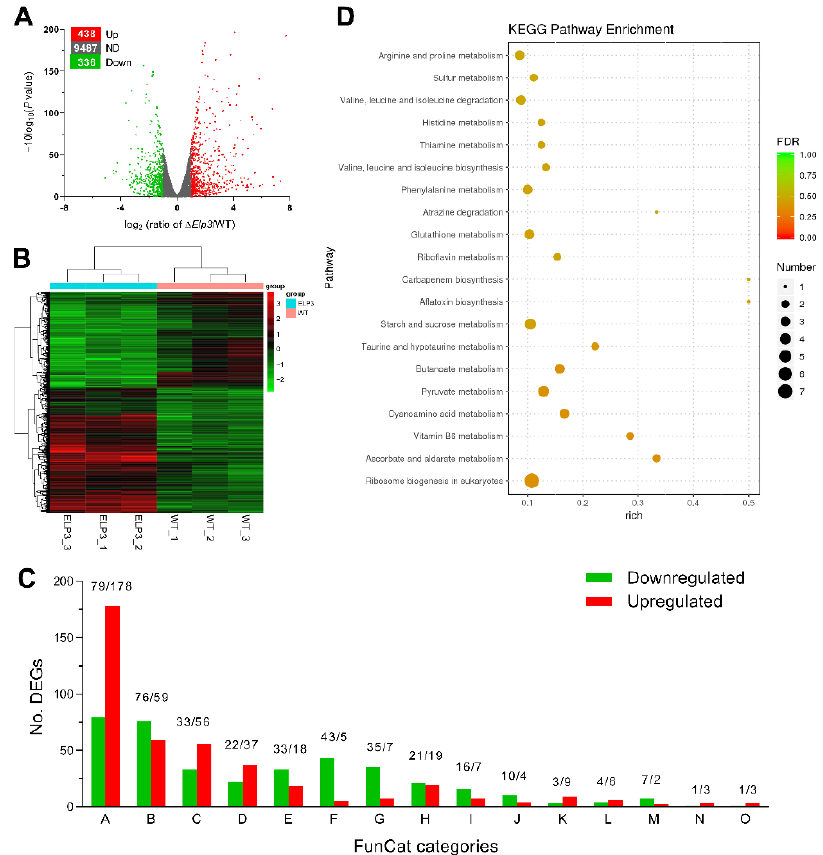
Figure 5. Comparative transcriptomic analyses of Δ BbElp3 and wild-type B. bassiana . ( A ) transcriptome. ( A ) Distributions of p -values and ratios for the genes identified to be downregulated, upregulated, or not differentially regulated (ND) in Δ BbElp3 versus the wild type. ( B ) Cluster analysis of the 775 differentially expressed genes (DEGs) found in the transcriptomic analyses of the Δ BbElp3 mutant versus wild-type strains. ( C ) FunCat annotation into 15 functional categories of significantly regulated genes in Δ BbElp3 versus wild type. A, metabolism; B, protein with binding function or cofactor requirement; C, cell rescue, defense, and virulence; D, cellular transportation; E, protein fate; F, transcription; G, cell cycle and DNA processing; H, biogenesis of cellular components; I, cellular communication/signal transduction mechanism; J, regulation of metabolism and protein function; K, energy; L, cell type differentiation; M, protein synthesis; N, systemic interaction with the environment; O, cell fate. ( D ) Counts and confidence intervals of differentially expressed genes enriched into the top 20 KEGG pathways in Δ BbElp3 versus the wild type.